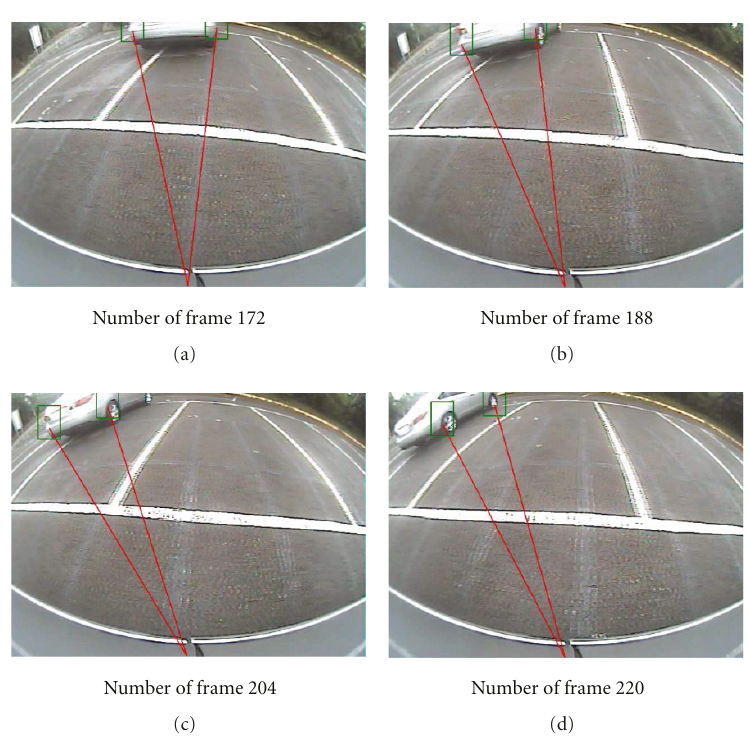
Figure 24: Results of obstacle tracking in Scenery